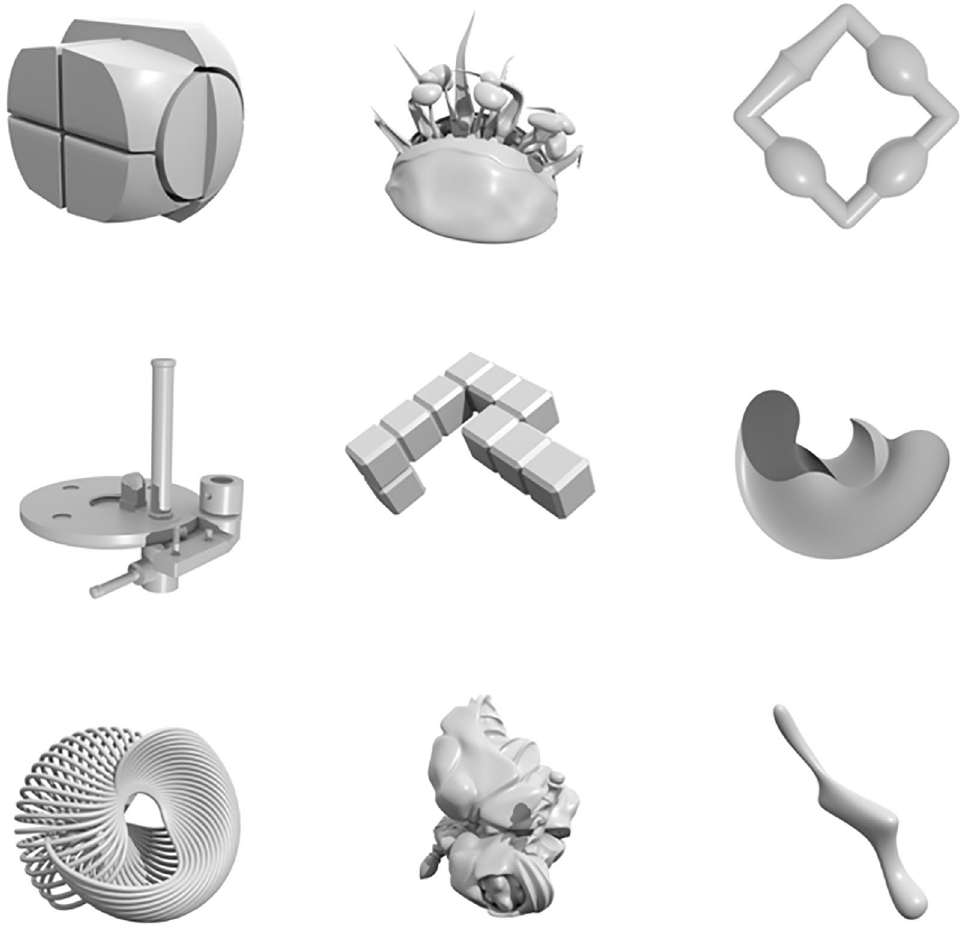
Figure 2. Representative examples of synthetic, computer-generated images used as stimuli in our one-shot learning evaluation. The decision to use synthetic stimuli was made because we aimed to test the human versus algorithm ability to generalize from one experience; as such, we could not use stimuli found in the natural world that participants would have had past experience